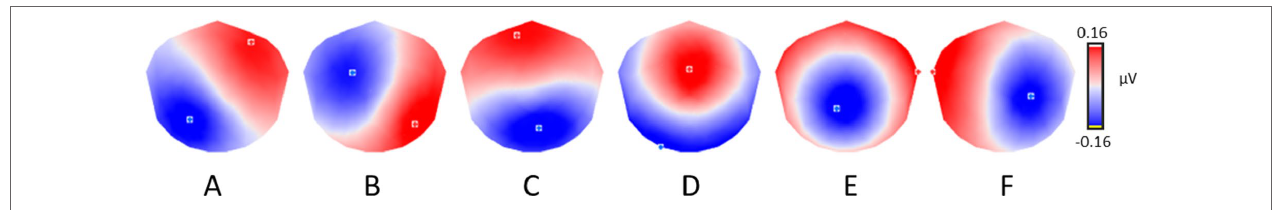
FIGURE 2 | The six microstate topographies identified in the global clustering across all